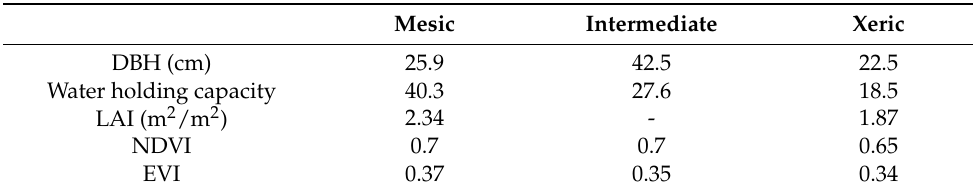
Table 1. Description of the three eddy covariance (EC) flux sites at the Jones Center at Ichauway (JCI), Newton, GA, USA. Mesic Intermediate Xeric DBH (cm) 25.9 Water holding capacity 40.3 LAI (m 2 /m 2 ) NDVI